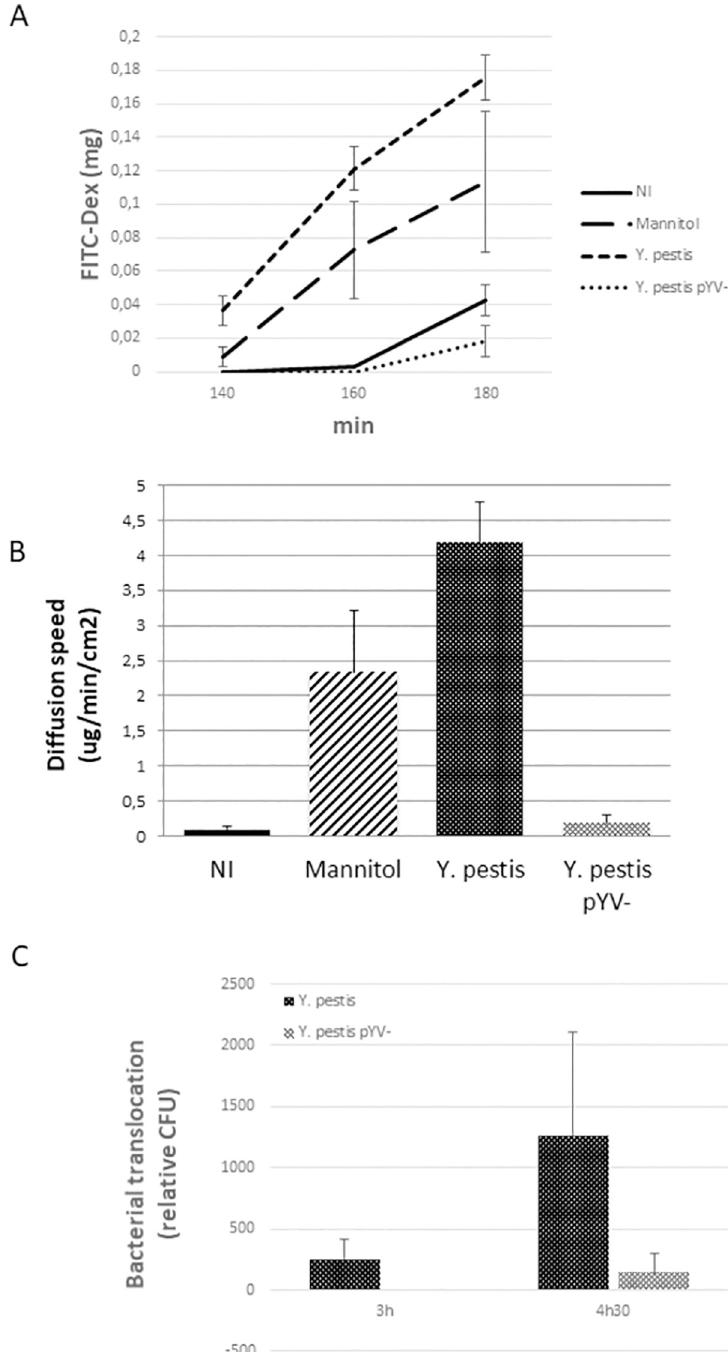
Fig 5. Permeability of Y . pestis -infected HDMEC. HDMEC monolayers cultured on Transwells (filter 0.4 μ m) were infected (MOI = 100) for 2.5h with Y . pestis CO92 or its pYV/pCD1 cured derivative. Permeability was measured using FITC-Dex (4kDa) ( A ) and the diffusion speed calculated ( B ). Mannitol was used as positive control for junction opening. C. The crossing of bacteria was measured using Transwells of lower filter capacity (3 μ m).